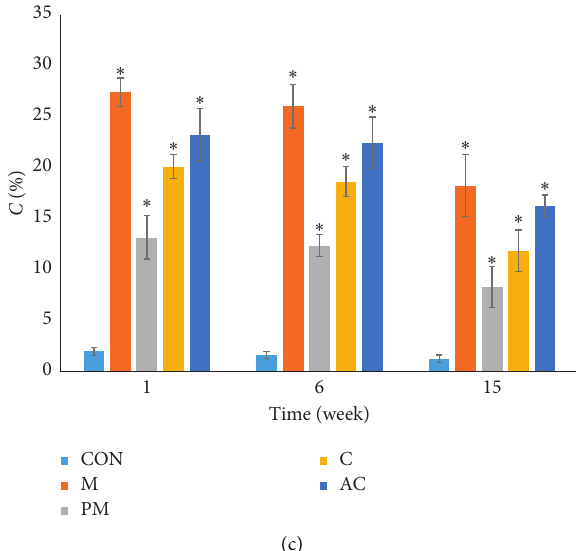
Figure 6: Changes in soil nutrient levels over 15 weeks as a function of treatment: (a) nitrogen; (b) phosphorus; and (c) organic carbon. M: molasses; C: plant compost; PM: papermill sludge; AC: activated carbon; and CON: control. ( ∗ ) indicates that data for the treatment were significantly different ( p < 0.05) from the control.